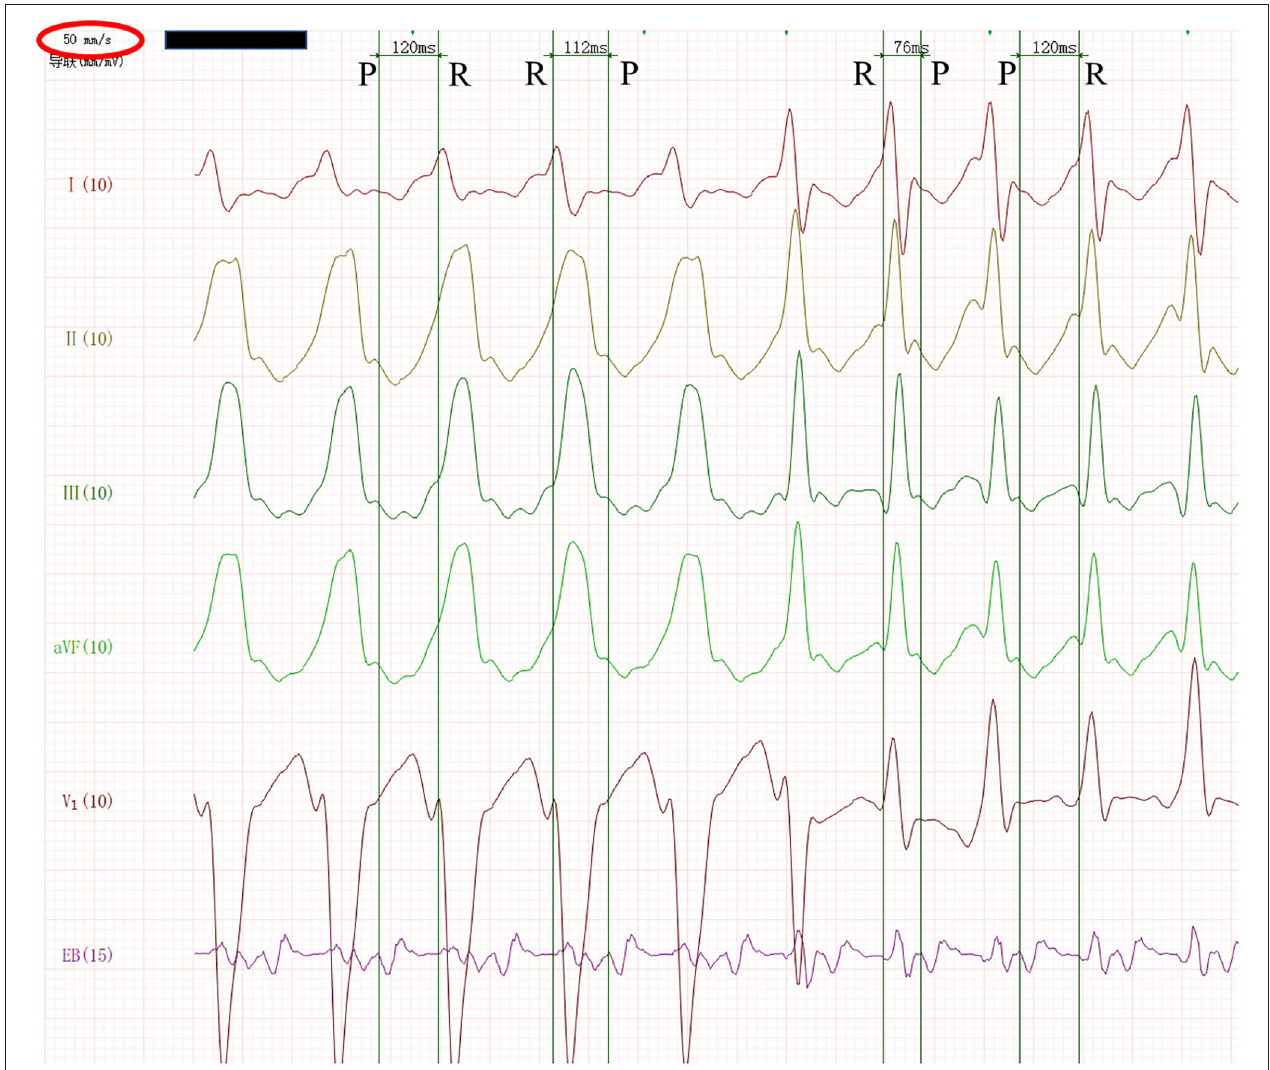
FIGURE 2 | Wide QRS tachycardia suddenly and automatically changed to narrow QRS tachycardia. After zooming in the image and slowing down the paper speed to 50 mm/s, we measured the ECG in the esophageal lead. The RP interval was 112ms, and the PR interval was 120ms in wide QRS tachycardia, while the RP interval was 76ms and the PR interval was 120ms in narrow QRS